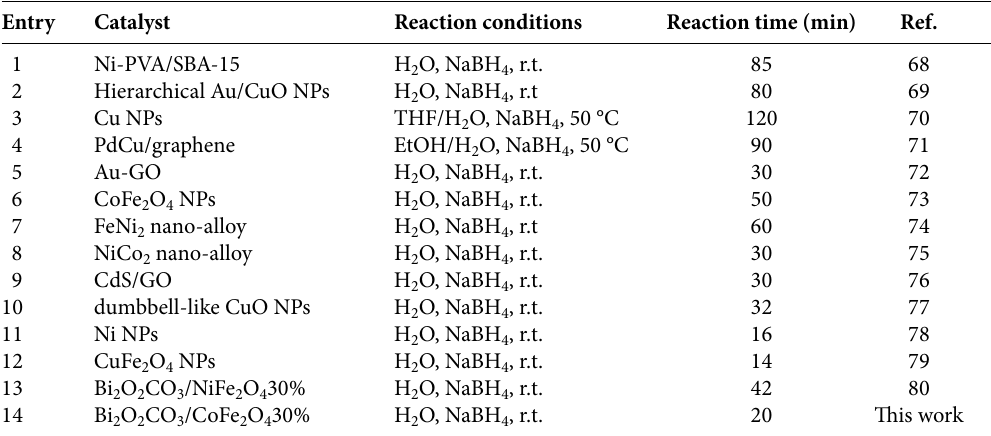
Table 1. Comparison of the result obtained for the complete reduction of 4-NP in the present work with those obtained by some reported catalysts. Entry Catalyst Reaction conditions Reaction time (min)